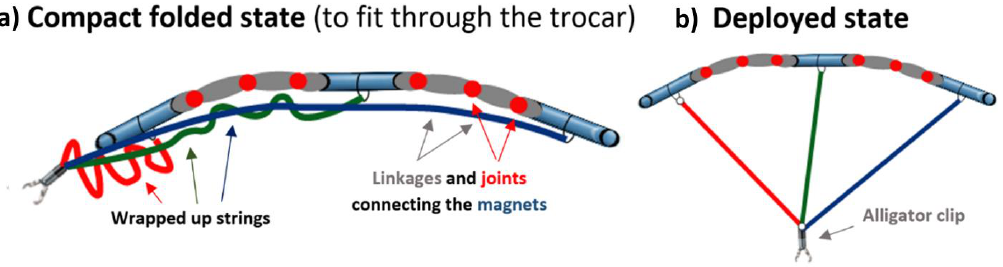
Figure 4. ( a ) Initial design concept of a magnetic anchoring and actuation system with external mag- nets, internal rod magnets, and adjustable strings, facilitating the sideways folding of the liver. The spacing of the external stabilizing magnets would require extra consideration in the case of